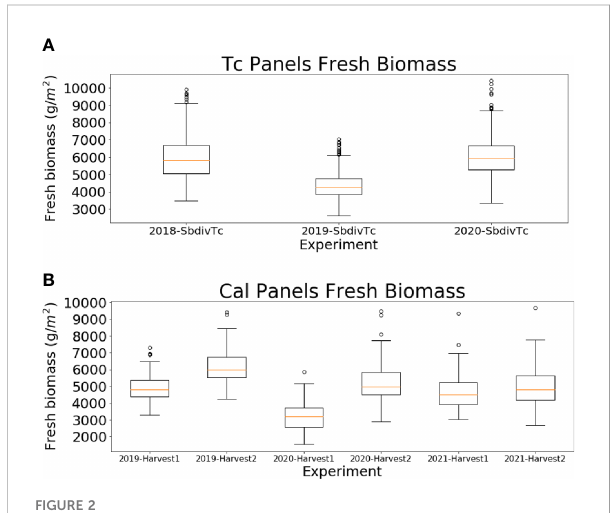
FIGURE 2 Box plot for (A) the end-of-season fresh biomass data for the Tc panels in 2018, 2019 and 2020 and (B) the two machine harvested fresh biomass data for the Cal panels in 2019, 2020 and 2021.